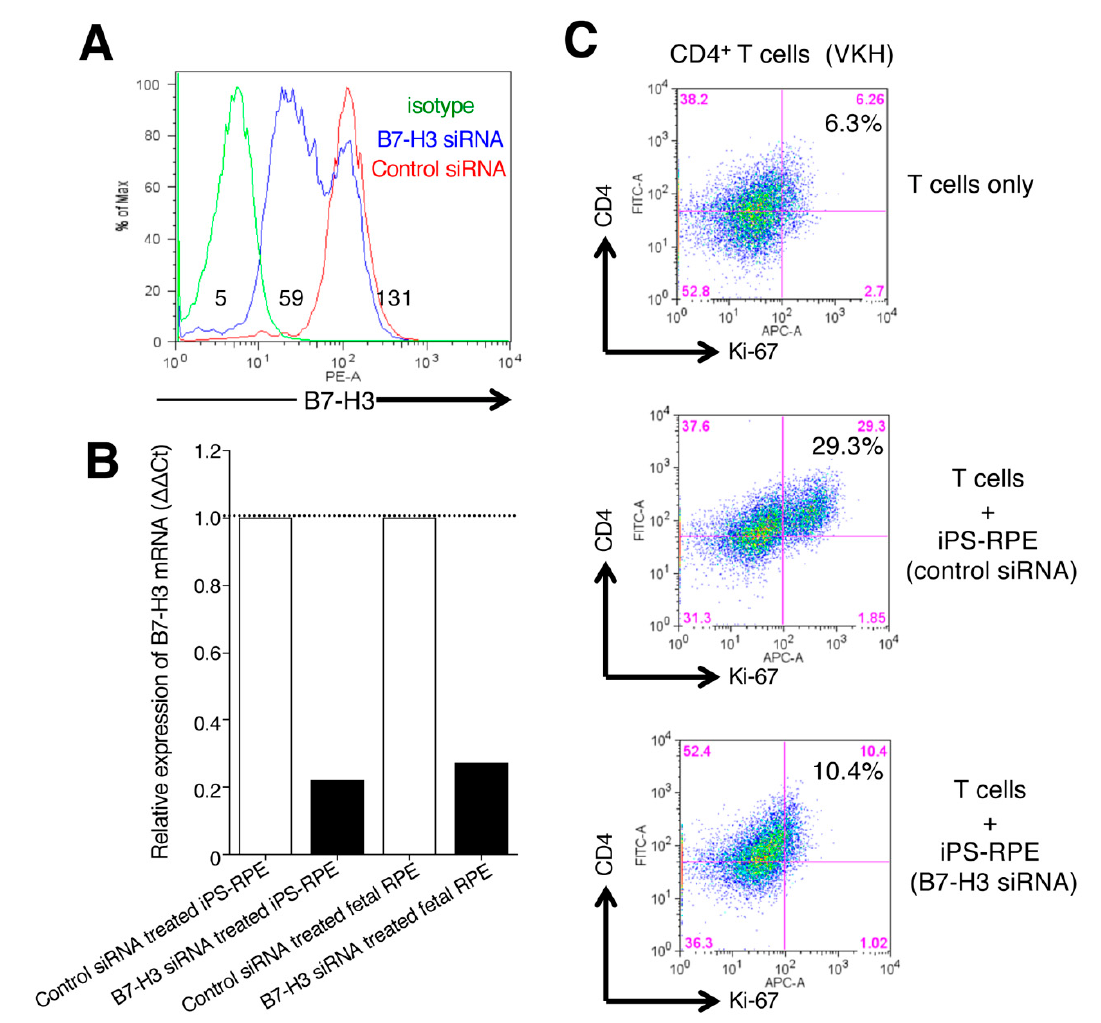
Figure 8. Effect of B7-H3 expression by iPS-RPE cells on the stimulation of T-cell activation. ( A ) B7-H3-siRNA-transfected iPS-RPE cells (TLHD1) were harvested on day 3 and examined for expression of B7-H3 by flow cytometry. Control-siRNA-transfected cells were also analyzed. The numbers in the histograms indicate MFI. Data are representative of 2 experiments. ( B ) B7-H3-siRNA-transfected iPS- RPE cells (TLHD1) or control RPE cells (fetal RPE cells) were examined for expression of B7-H3 mRNA by qRT-PCR. Data are representative of 3 experiments. Control-siRNA-transfected cells were also analyzed ( ∆∆ Ct: control cells = 1). ( C ) CD4 + T cells from a VKH disease patient were cocultured with B7-H3-siRNA-transfected iPS-RPE (or control-siRNA-transfected) cells and evaluated by Ki-67 staining (for proliferation) of T cells. T cells were cocultured with to 2 × 10 4 (T cell:RPE ratio = 100:1) iPS-RPE cells. Data are representative of 3 individual experiments. Numbers in the histograms indicate the percentage of cells double-positive for CD4 and Ki-67.